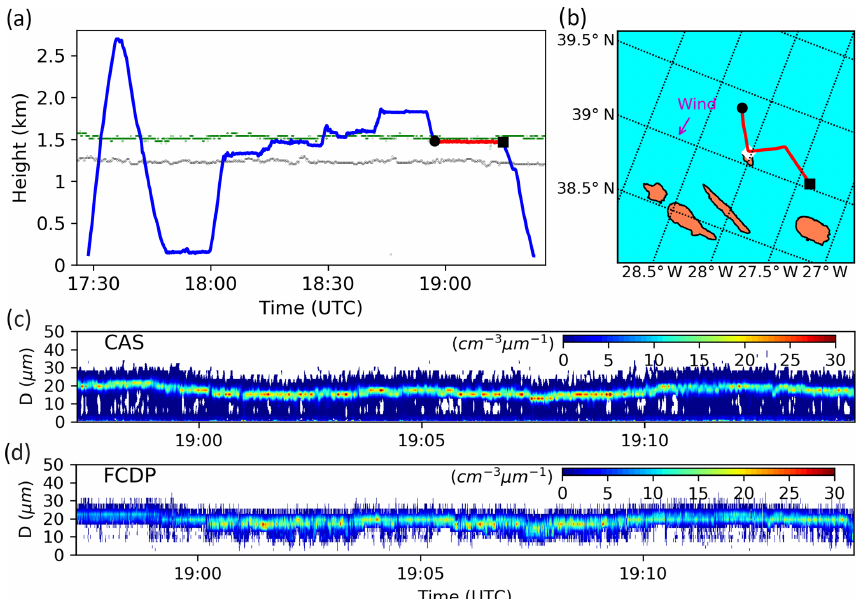
Figure 2. Time series of flight patterns and cloud droplet size distributions for our study period. (a) Time series of flight altitude, where gray and green lines represent, respectively, the cloud-base and top heights from the ground-based measurements. The red line indicates the in-cloud flight leg used in this study, and black dots represent the beginning and ending points of the selected flight leg. (b) Top view of the flight path for the selected in-cloud flight leg in (a) . Ocean is bluish green, land is coral, and the ENA facility is marked by a white dot. Measured cloud droplet size distributions in the red flight leg are obtained from the (c) Cloud Aerosol Spectrometer (CAS) and (d) Fast Cloud Droplet Probe